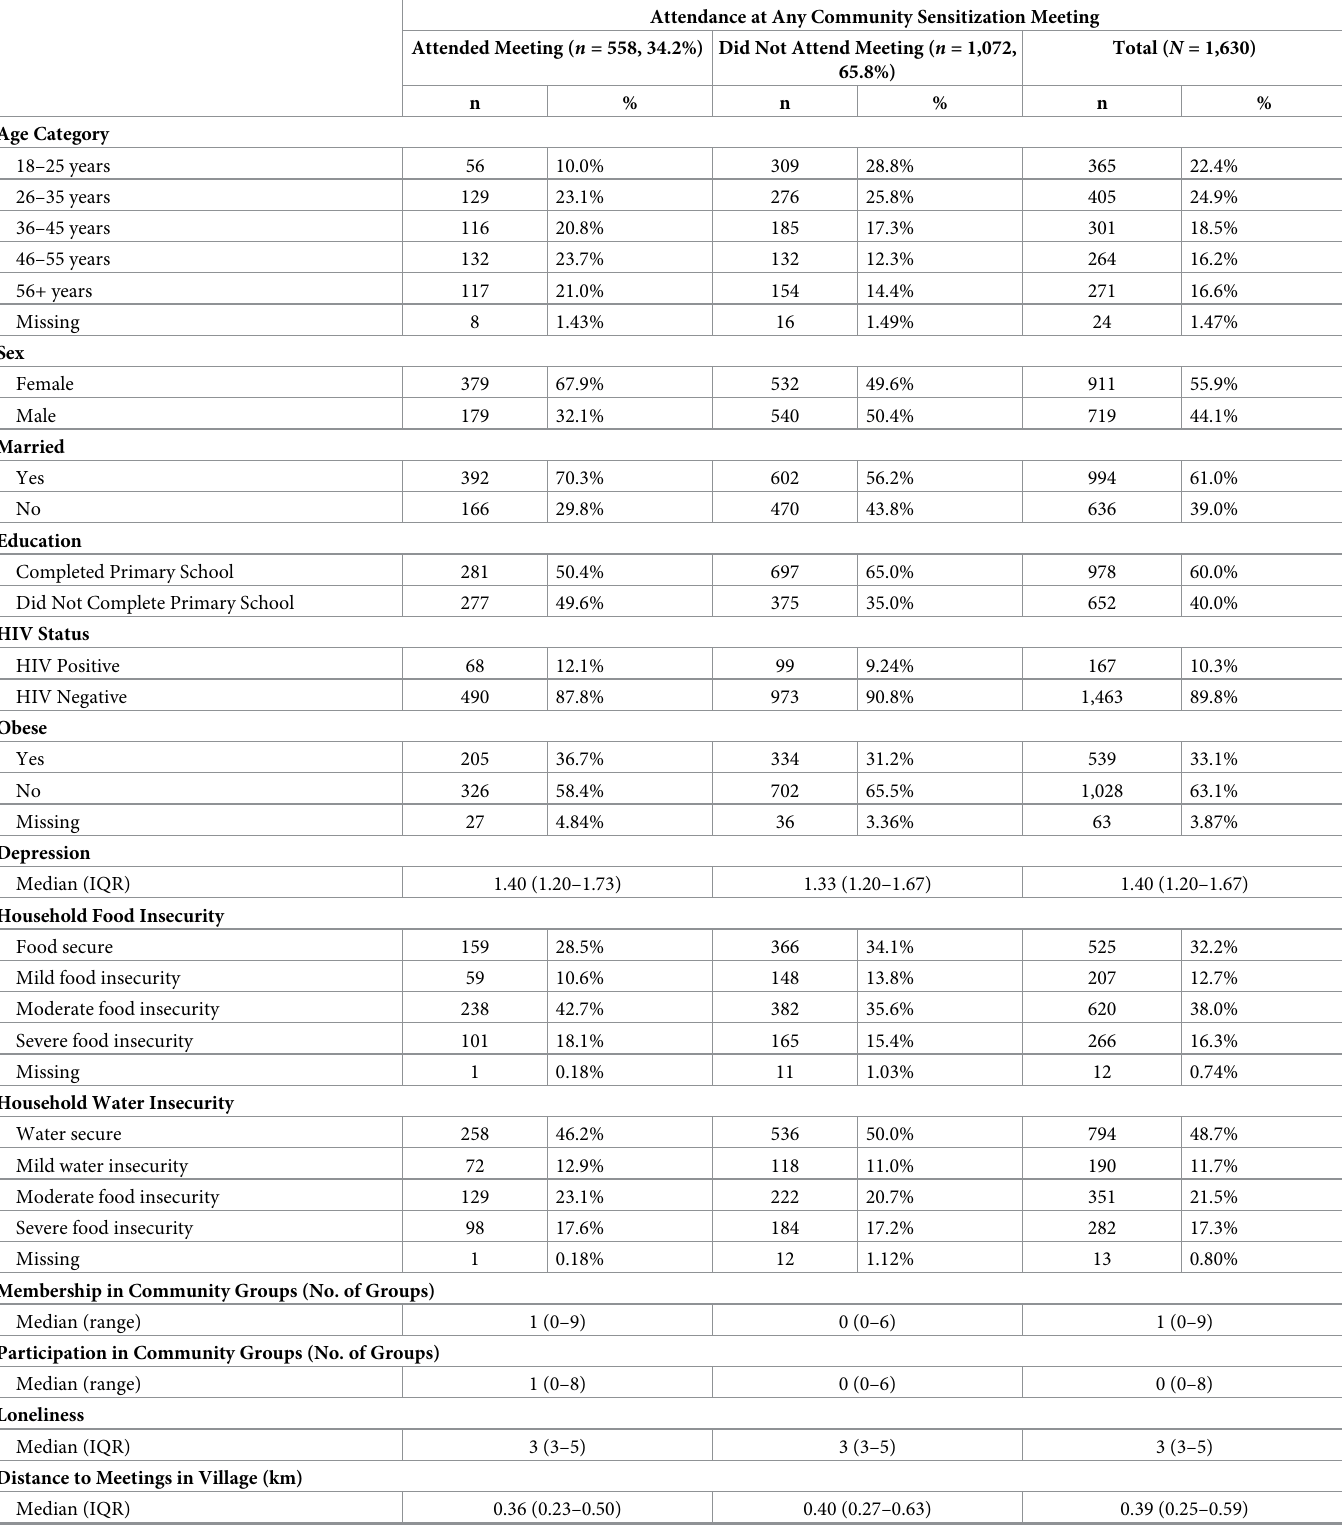
Table 2. Characteristics of study participants stratified by attendance or nonattendance at any community sensitization